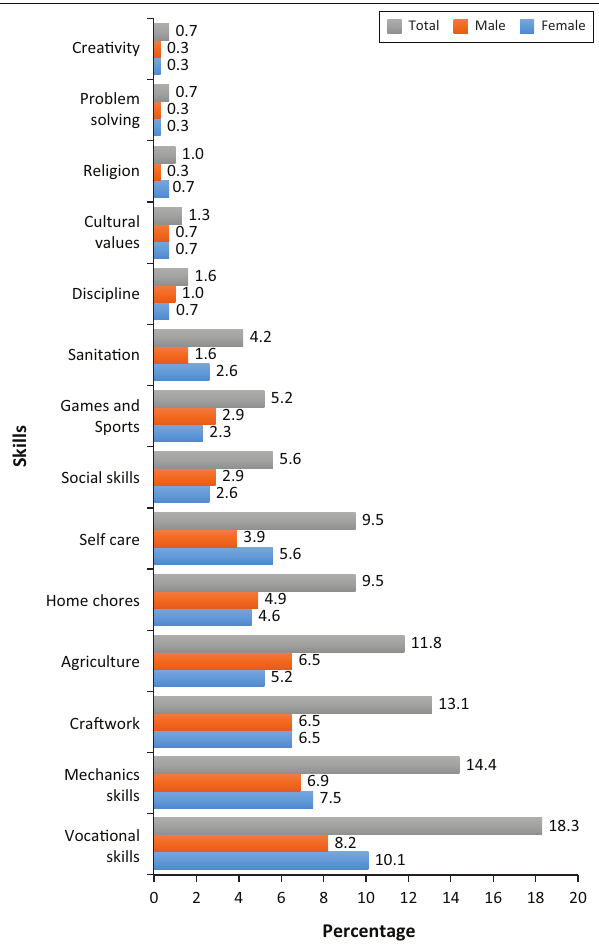
20Voca(cid:31)onal FIGURE 1: Perception of participants by gender on what children should learn.